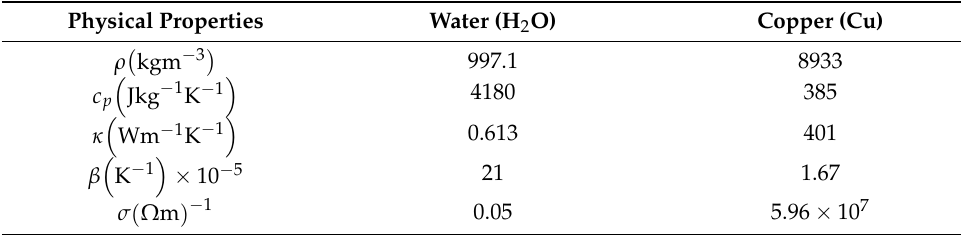
Table 2. Numerical values of thermal properties of nanomaterial Ali et al.